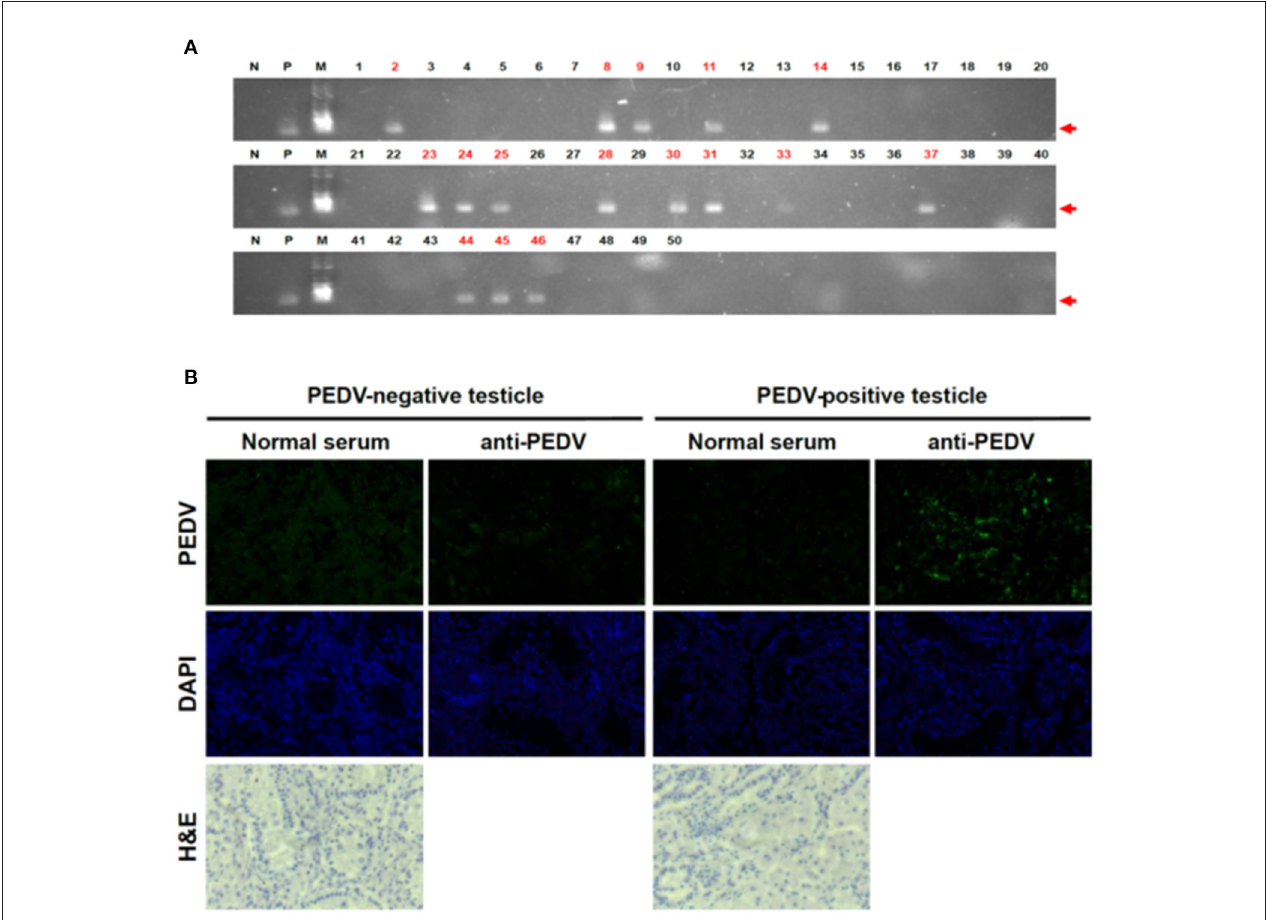
FIGURE 1 | Detection of PEDV in piglet testicles tissues. (A) RT-PCR results on testicles of piglets. We performed RT-PCR targeting for PEDV M gene (N, negative control; P, positive control; M, marker). Red numbers indicate positive samples. (B) IHC on testicle samples clearly confirmed PEDV positive. We used PEDV-positive sera as the primary antibody and used anti-mouse IgG conjugated with Alexa 488 as the second